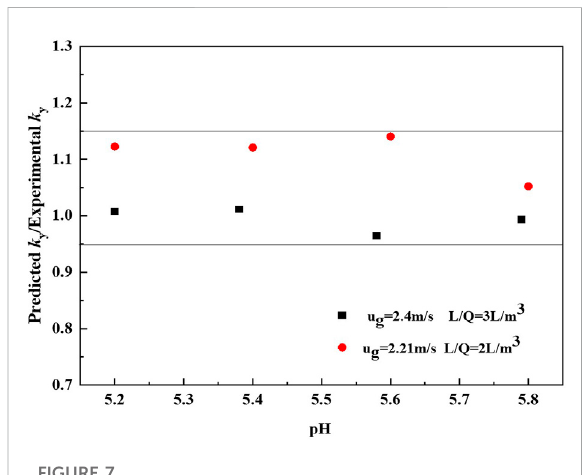
FIGURE 9 Deviation of the predicted k y from the experimental k y at different L /